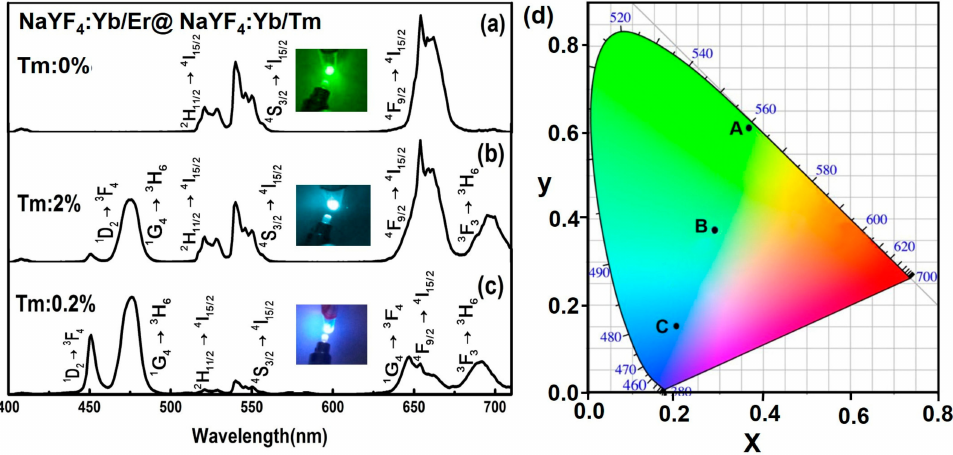
Figure 4. ( a — c ) UC luminescence spectra of the NaYF 4 :Yb/Er (20/2 mol %)@NaLuF 4 :Yb/Tm(20/ x mol %, x = 0, 2, 0.2) with different concentrations of Tm 3+ in the shell under 980 nm laser excitation (~15.5 W/cm 2 ); ( d ) CIE chromaticity coordinates of the emission for different concentrations of Tm 3+ (Tm 3+ : 0%, 2%, 0.2%) in the